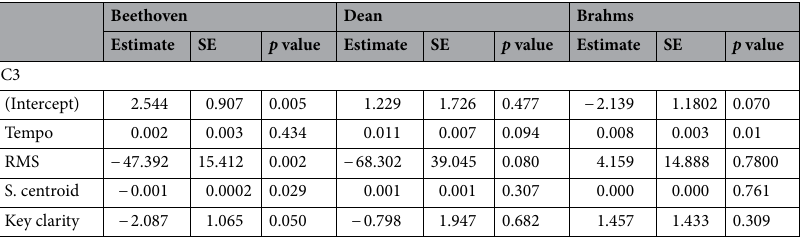
Table 3. Logistic regressions for single physiological measure of respiration rate, skin conductance and heart rate synchrony per piece across all concerts (C1, C2, and C3). Synchrony (HS = 1, LS = 0) was the dependent variable, and tempo, key clarity, loudness, and spectral centroid (s. centroid) from the HS and LS bars as continuous predictors. The Bonferroni-corrected critical p value is 05/36 = 0.0014. Values highlighted in bold are statistically significant after Bonferroni corrections for multiple